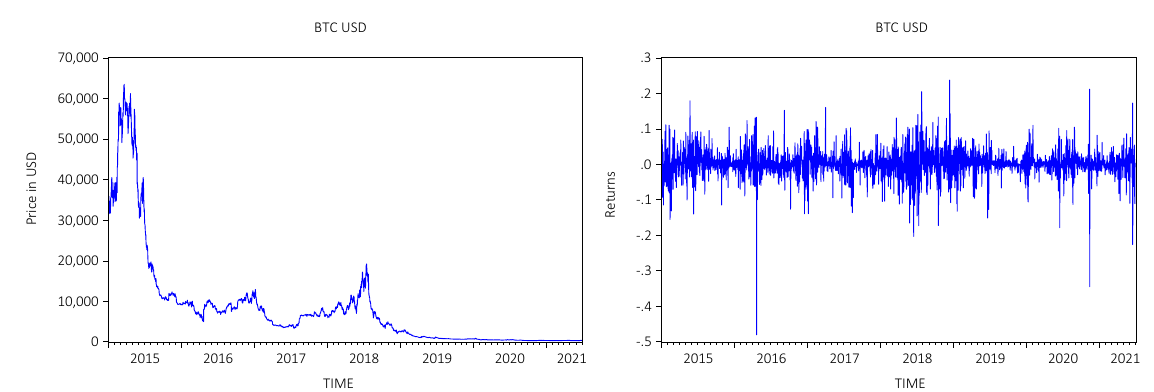
Figure 1. Time series plot of one-day BTC/USD prices (left) and one-day log returns (right)